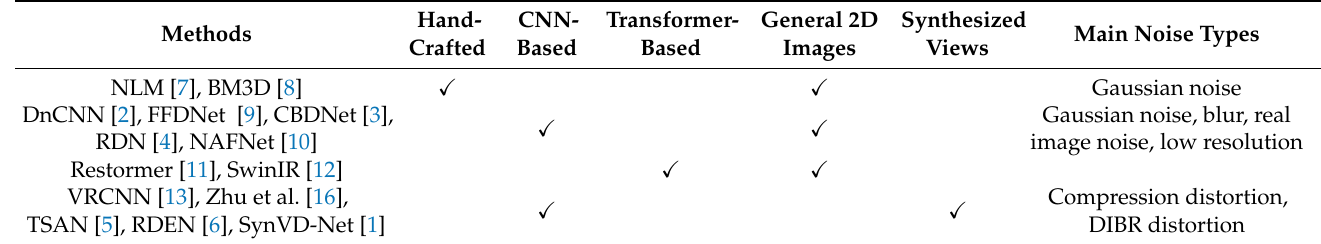
Table 1. The attributions of state-of-the-art image denoising and SVQE